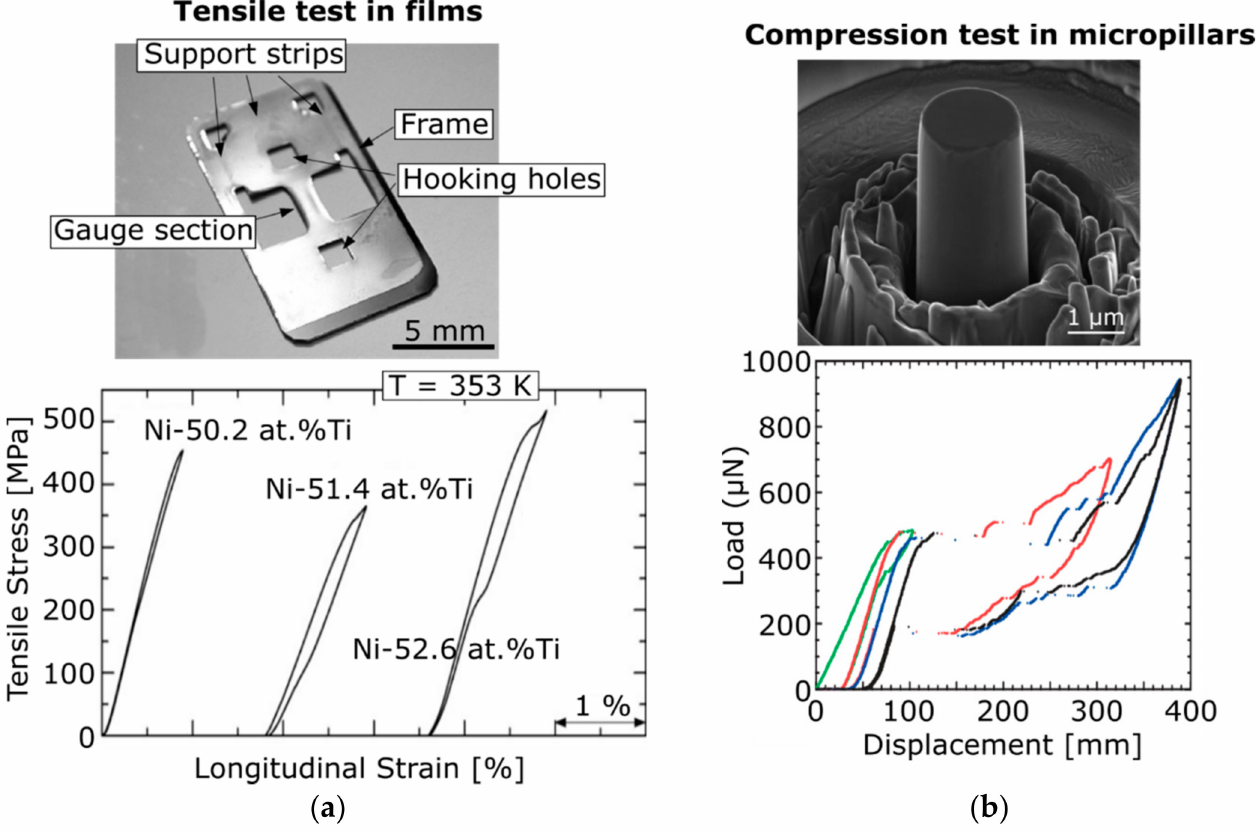
Figure 6. Uniaxial testing of miniaturized SMA samples: ( a ) Tensile test of a 4 µ m-thick NiTi film-shaped sample geometry facilitating the clamping on a tensile machine reproduced from [134] with permission from Elsevier 2007. ( b ) Compression tests of Cu-Al-Ni micropillars using nanoindentation reproduced from [103] with permission from Wiley